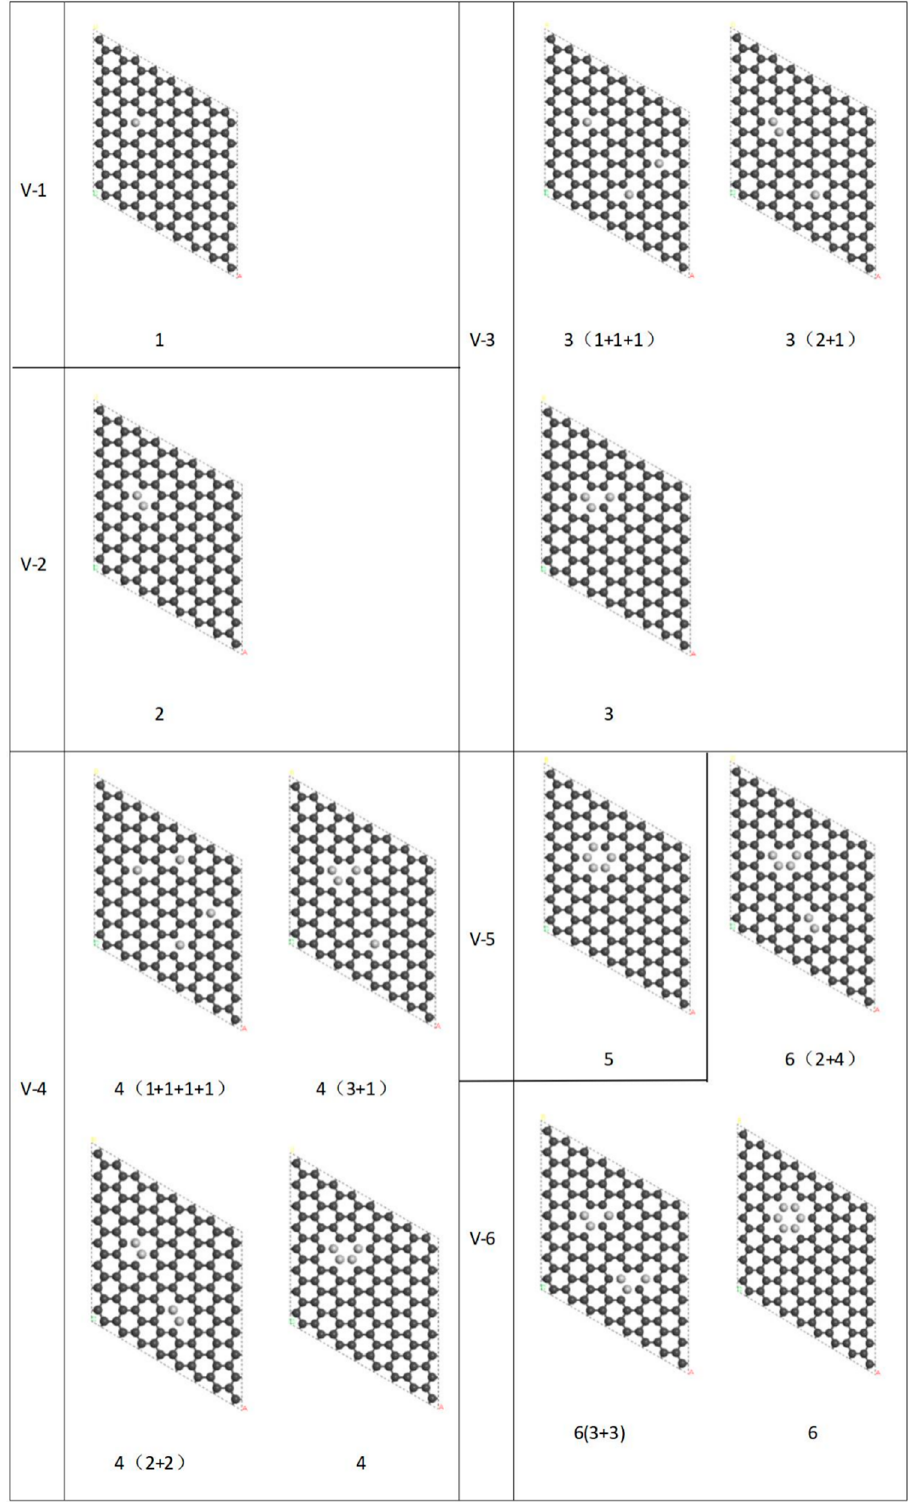
Figure 1. Types of vacancy defect in a supercell of graphene. The dark spheres represent carbon atoms and the light spheres represent missing carbon atoms.